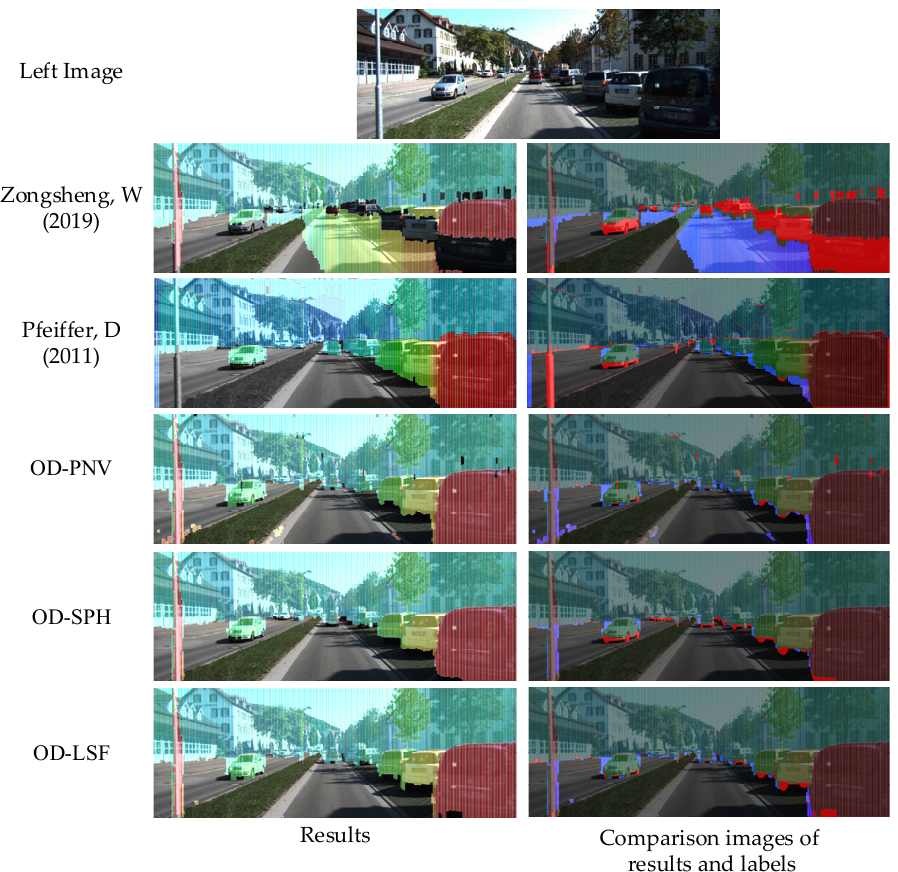
Figure 14. Scene 1 obstacle detection results. Zongsheng, W (2019) represents the Reference [19], Pfeiffer, D (2011) represents the Reference [10].